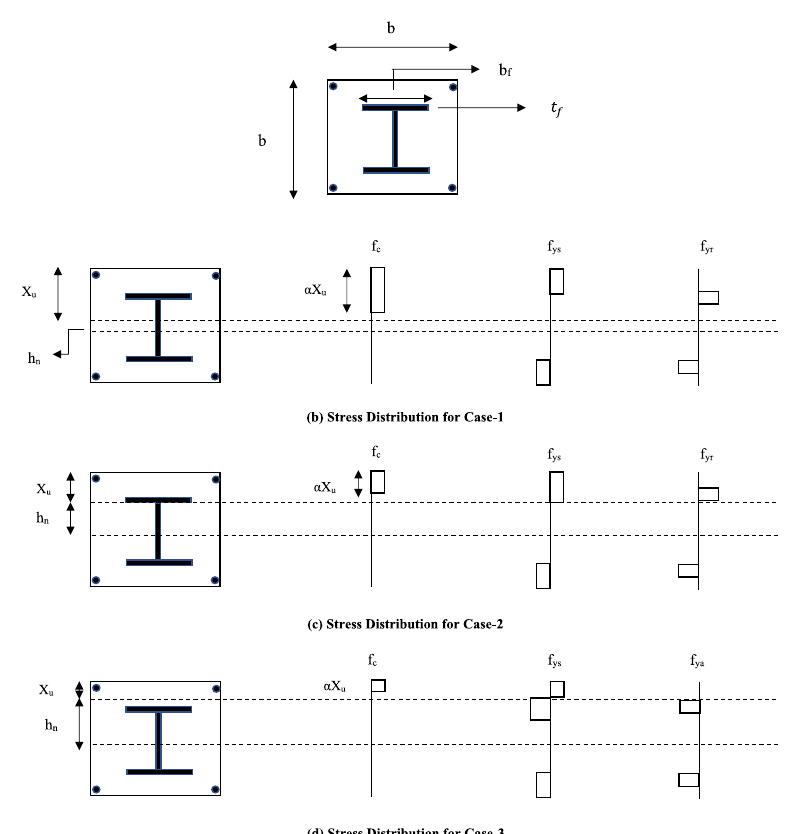
Fig. 10 Stress distribution diagram at point B for different